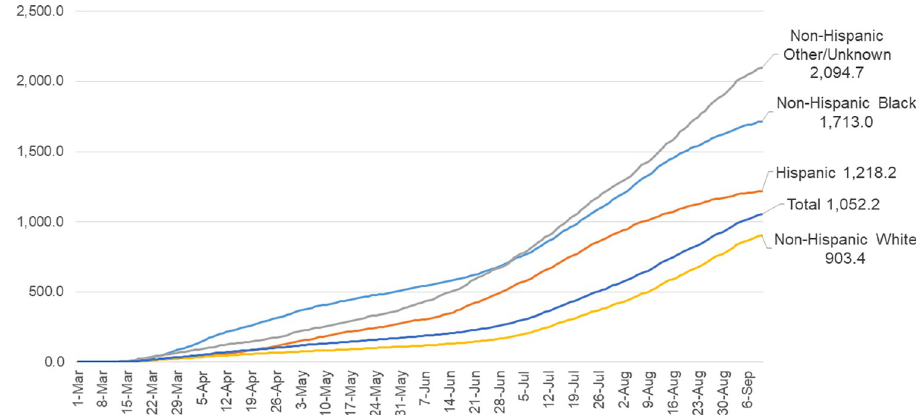
Fig 1. Cumulative COVID-19 related cases per 100,000 by race and ethnicity, Missouri residents, Mar. 1, 2020 – Sep. 10, 2020. Source: Authors’ analysis of COVID-19 case data from the Missouri Department of Health and Senior Services and 2018 population estimates from the U.S. Census American Community Survey.